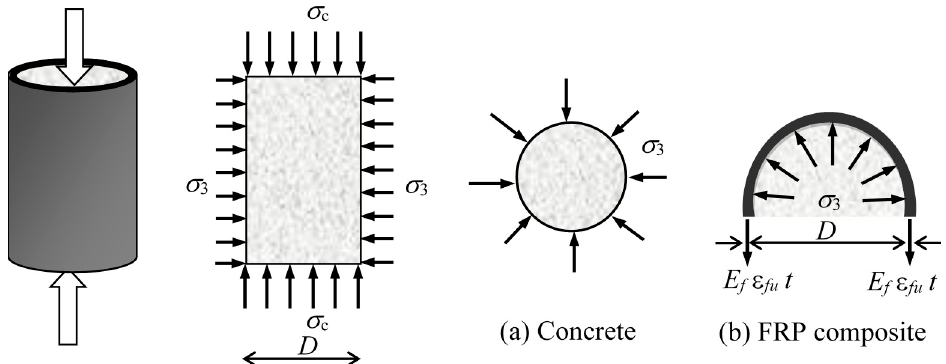
Figure 1. Development of confining pressure in FRP confined concrete. ( a ) Confining pressure to concrete; ( b ) Ultimate confining pressure by FRP composite on concrete.